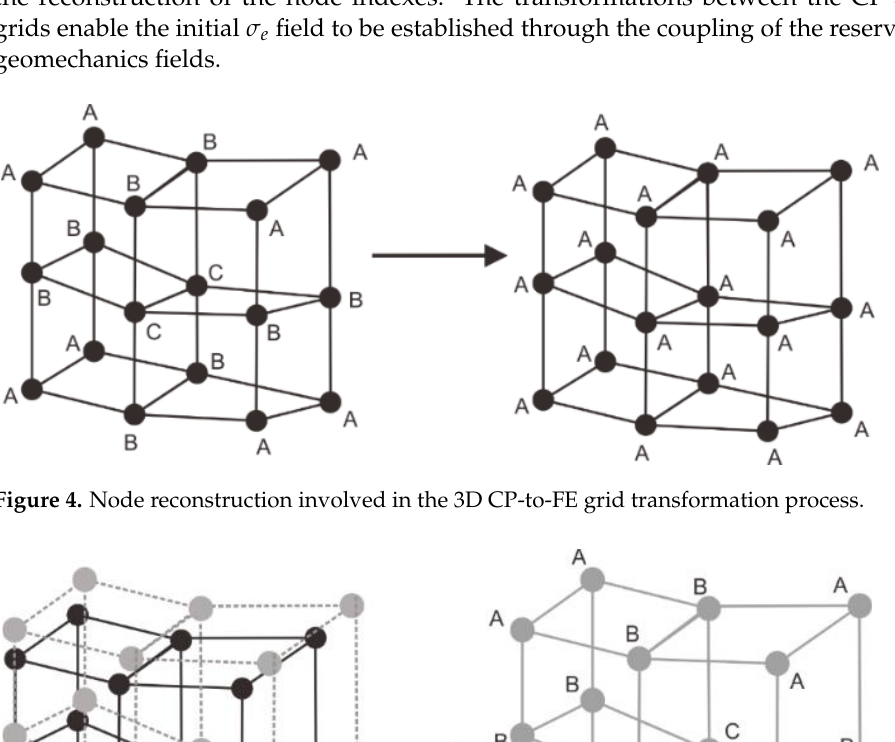
Figure 4. Node reconstruction involved in the 3D CP-to-FE grid transformation process.